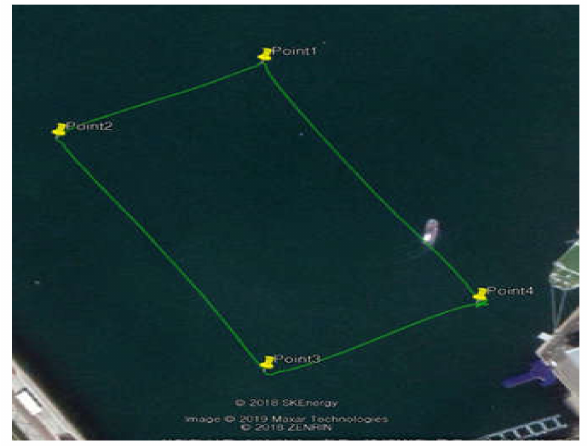
Figure 23. Waypoint tracking control results.